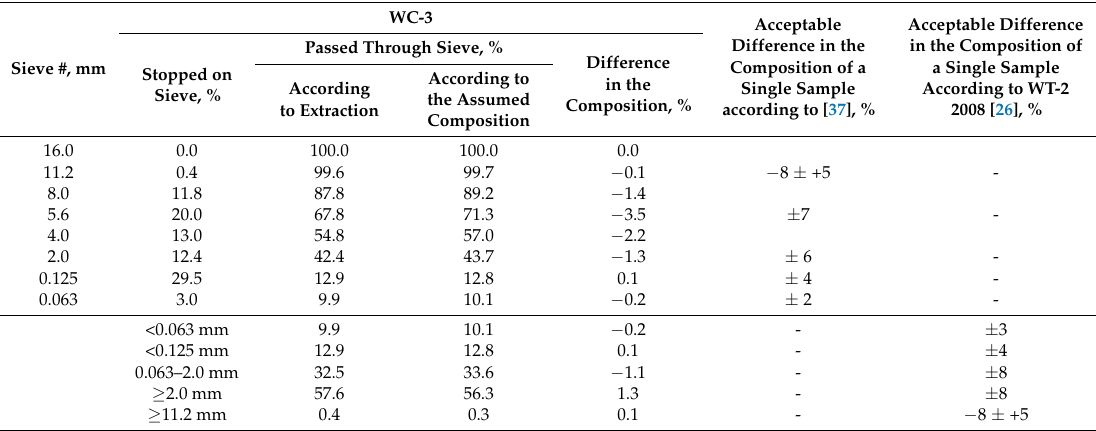
Table 10. Aggregate graining following extraction for WC-3.